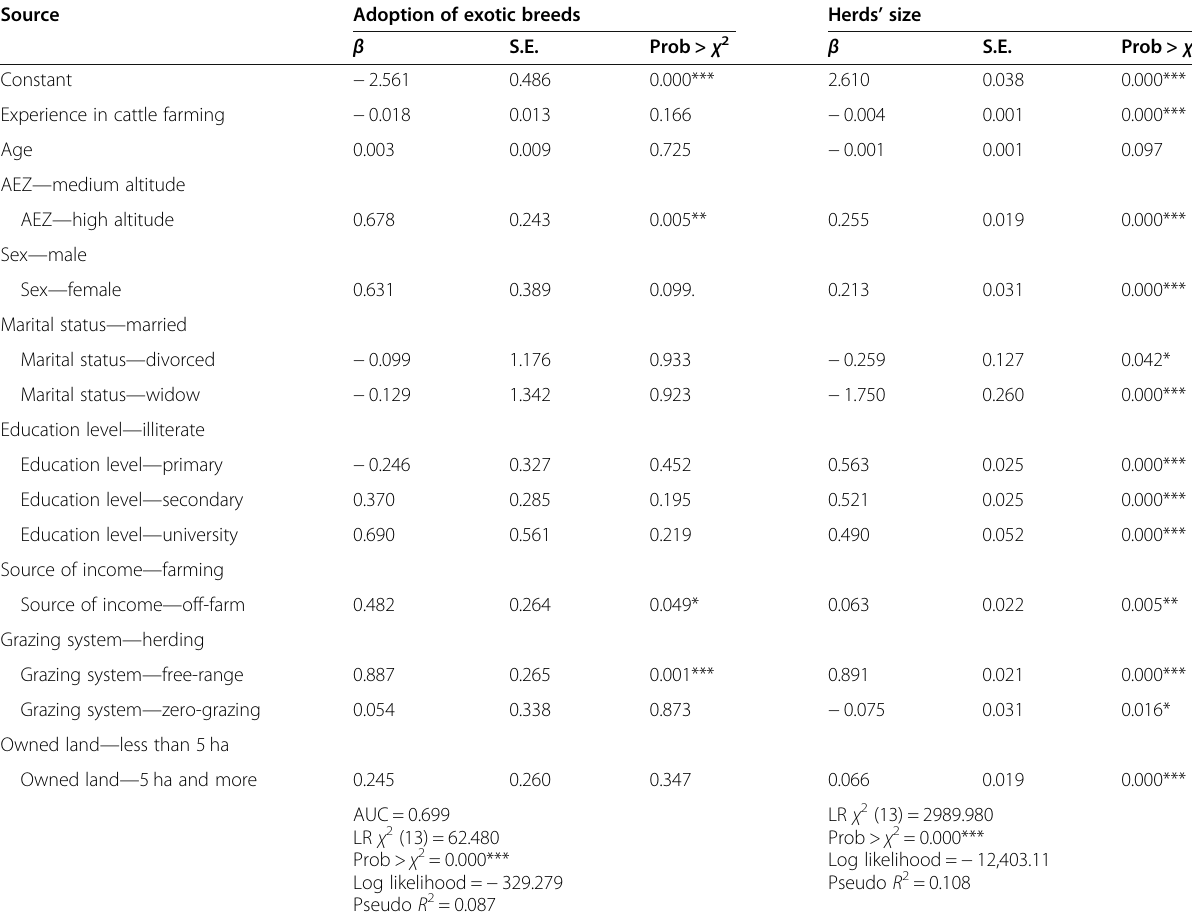
Table 3 Summary of the logit model and Poisson models of socio-economic determinants of adoption of exotic breeds and herd